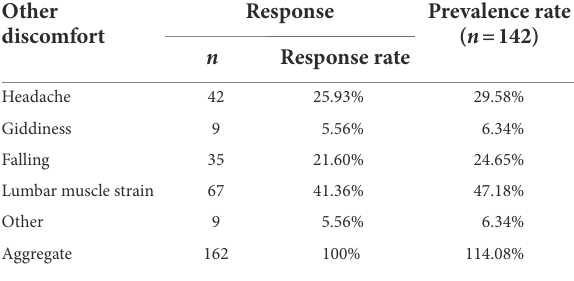
TABLE 6 Overall symptoms.